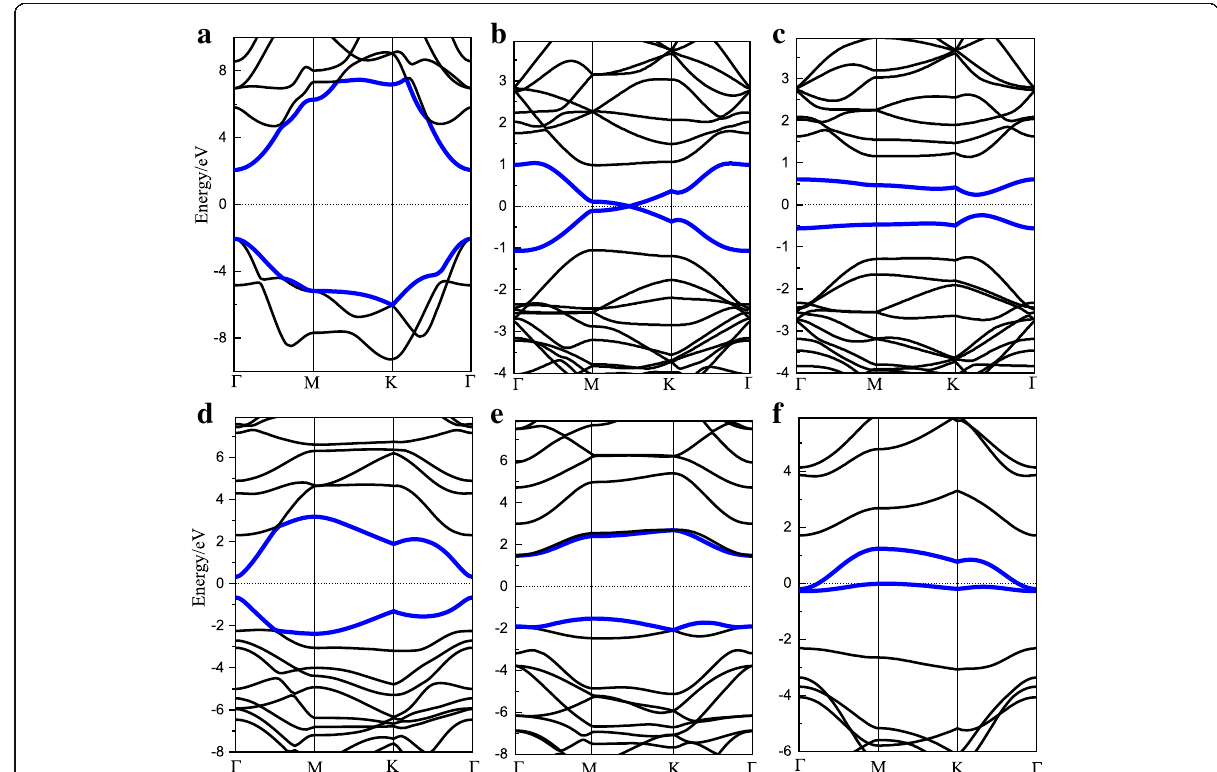
Fig. 4 Band structures of HGs. a 100%. b , c 6.25% pattern I and II. d , f 25% pattern I –